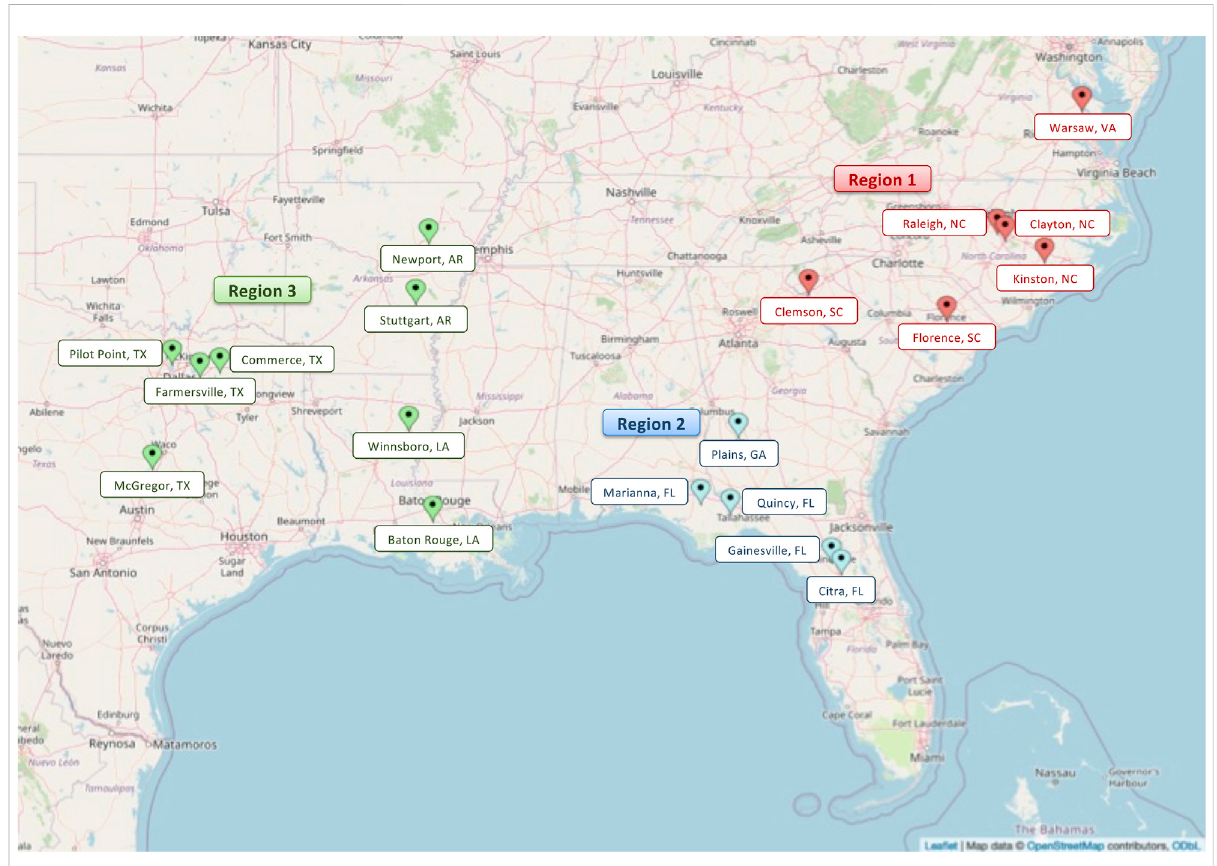
FIGURE 1 Map indicating the three major target population of environments (regions) (Boyles et al., 2019). In red indicating the Atlantic coastal plain correlatedtriallocations (region1),inblueGeorgiaandFloridalocations (region2)andingreenthegulfcoastlocations (region3).Pinpointedarethe 19 locations in eight states of the Southeastern US region were SunGrains breeding lines are evaluated